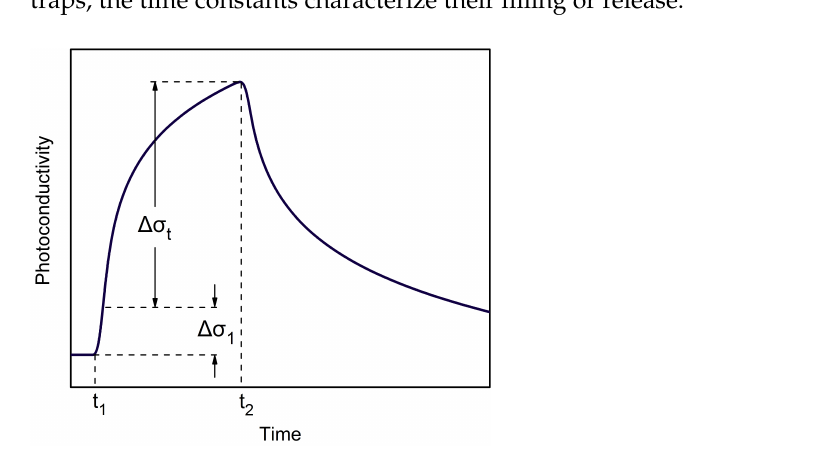
Figure 8. The typical temporal dependence of increase and decrease in photoconductivity for a crystal with traps under influence of